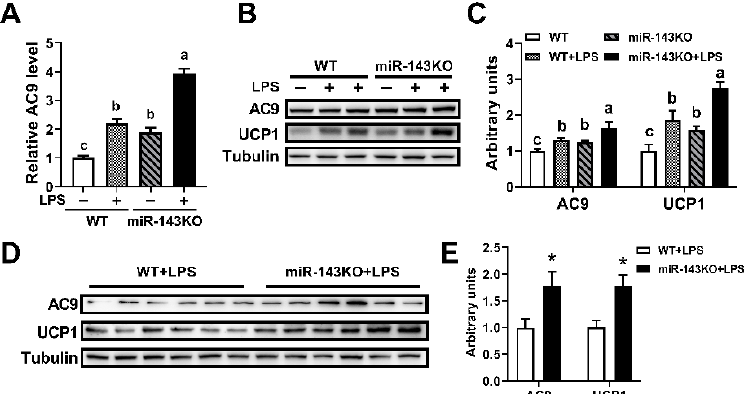
Figure 7. LPS regulates UCP1 expression through the miR-143-AC9 signaling pathway. ( A – C ) The AC9 mRNAs ( A ), and AC9, UCP1 protein ( B , C ) expression levels in WT or miR-143KO primary brown adipocytes treated with or without 0.2 µ g/mL LPS. ( D , E ) The AC9 and UCP1 protein expression levels in mice treated with 10 µ g/kg LPS. Data are presented as the mean ± SEM. * p < 0.05 vs. controls. Different letters above groups represent significant differences, with shared letters representing no significant differences, as determined by a two-tailed unpaired Student’s t -test ( E ) and two-way ANOVA followed by Tukey’s post hoc test ( A , C ).